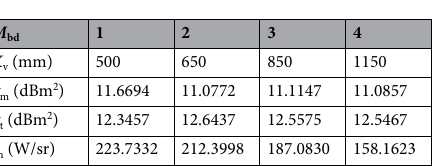
Table 2. Comparison of stealth indicators of aircraft under different M bd